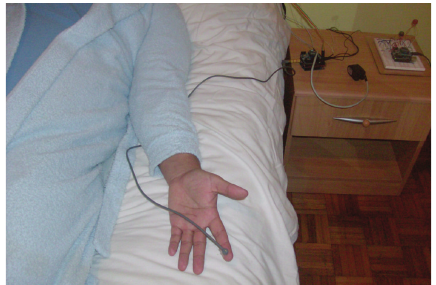
Figure 16: Placement of the body temperature sensor in the patient [14].